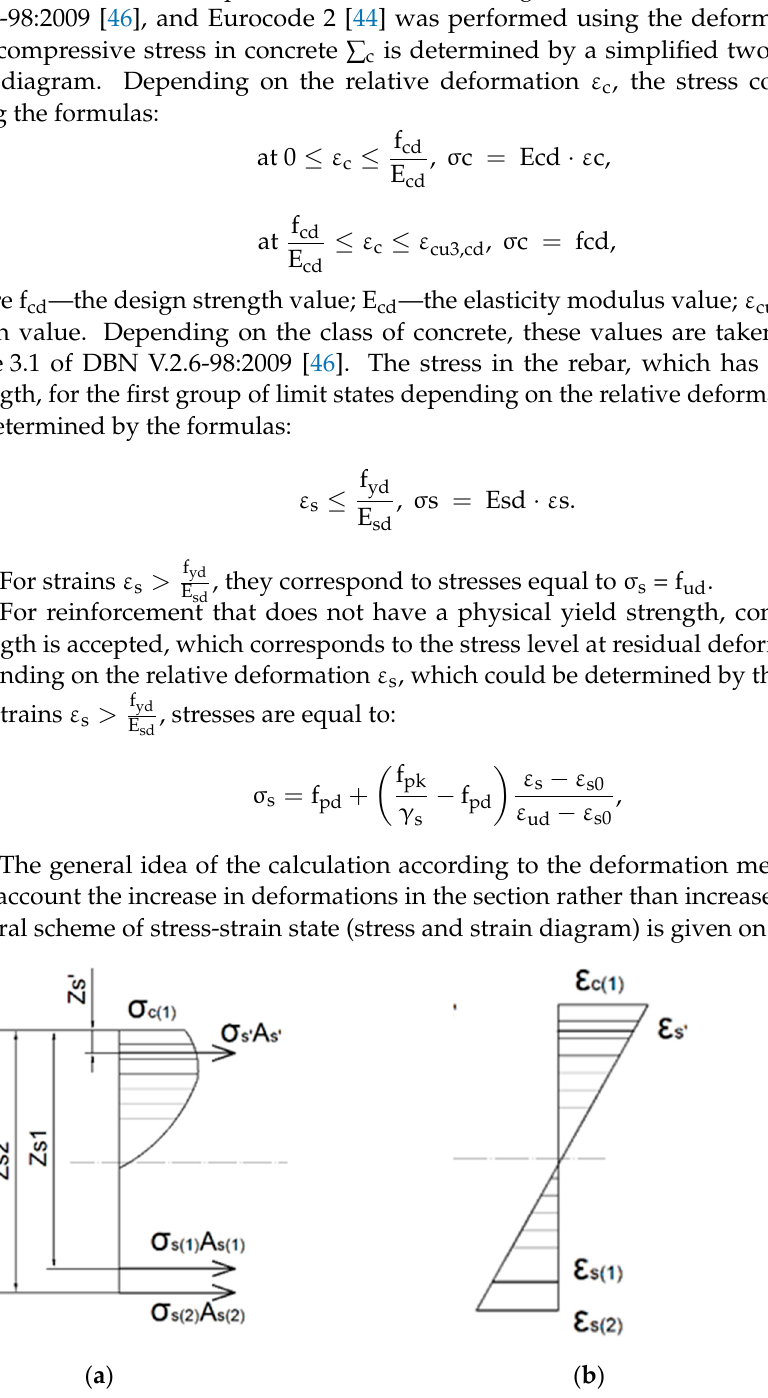
Figure 5. ( a ) Stress diagram for a bent reinforced concrete element with combined reinforcement; ( b ) strain diagram for a bent reinforced concrete element with combined reinforcement.